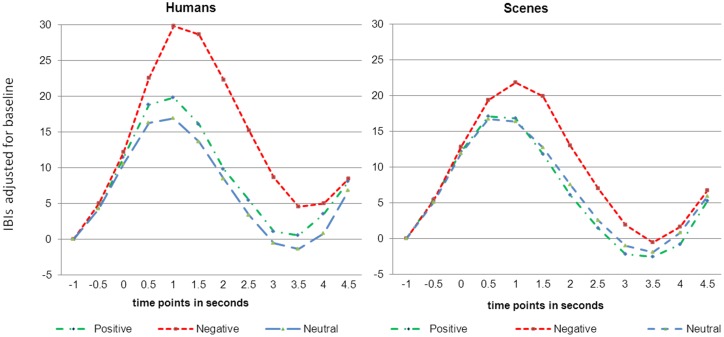
Baseline-adjusted IBIs (in milliseconds) in response to the IAPS pictures (t = 0 s).Left panel: pictures with humans present; right panel: pictures without humans.